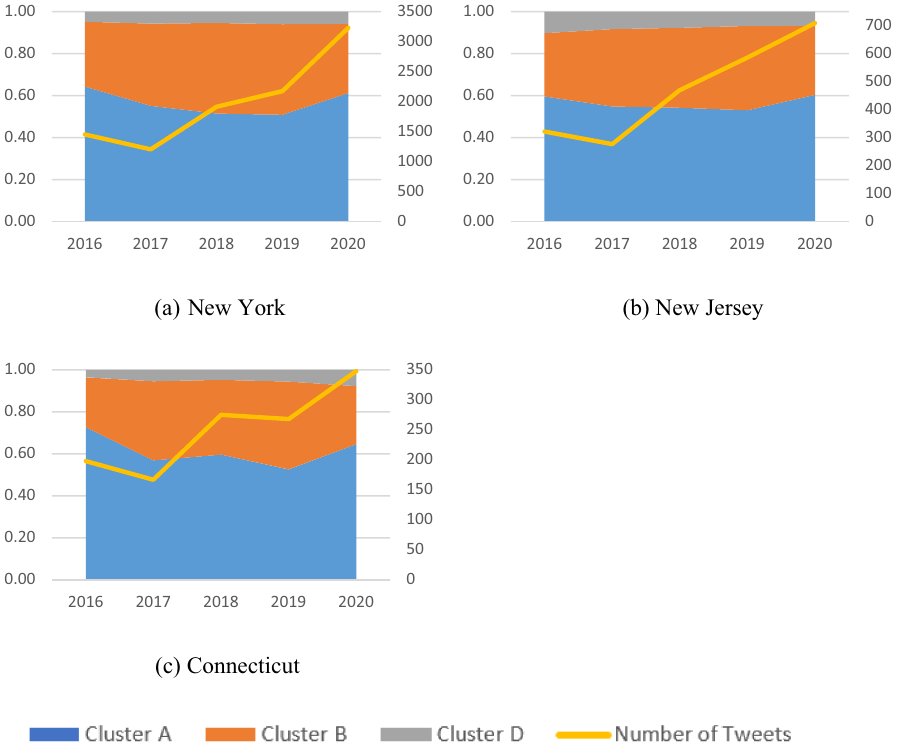
Figure 5. Changes in the proportion of clusters and the total number of tweets over the 5 years (2016–2020). The left and right vertical axes represent the proportion of clusters and the number of tweets, respectively.